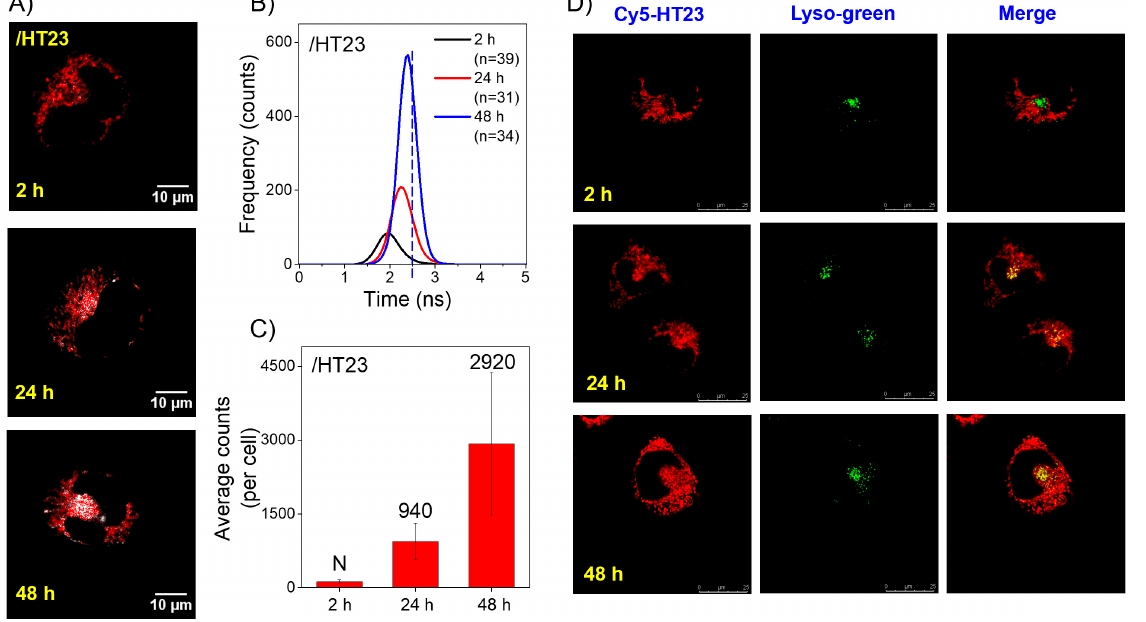
Figure 3. Imaging study of exogenous HT23 G4s in CL1-0 live cells. Time-gated FLIM images of 5 µ M o -BMVC mixed with 15 µ M HT23 G4s incubated with CL1-0 live cells for 2 h, 24 h, and 48 h ( A ). The corresponding plots of average photon counts of o -BMVC fluorescence per cell after 2 h, 24 h, and 48 h incubation of HT23 G4s with CL1-0 live cells ( B ). Histogram of the average photon counts per cell with a decay time ≥ 2.4 ns for each case, where N denotes negligible ( C ). Confocal images of Cy5-HT23 G4s incubated with CL1-0 live cells for 2 h, 24 h, and 48 h (left), and then stained by LysoTracker green at a concentration of 50 nM and incubated with the cells for 15 min (middle) together with their merges (right) ( D ).